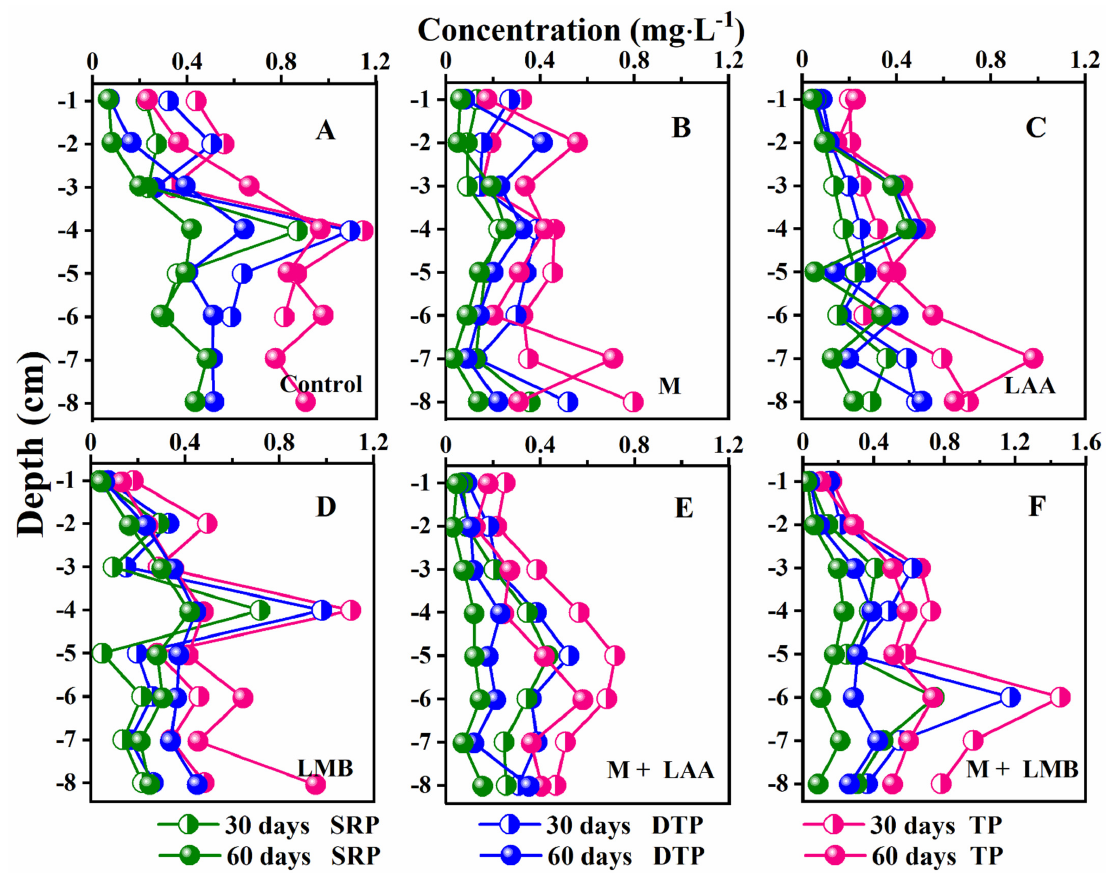
Figure 2. The changes of TP, DTP, and SRP concentrations in the porewater of the six treatments during the experiment. All data are triplicates. ( A – F ) indicate the concentration changes of TP, DTP, and SRP in sediment pore water of the Control, M, LAA, LMB, LAA+M, and LMB+M experimental groups on the 30-day and 60-day,